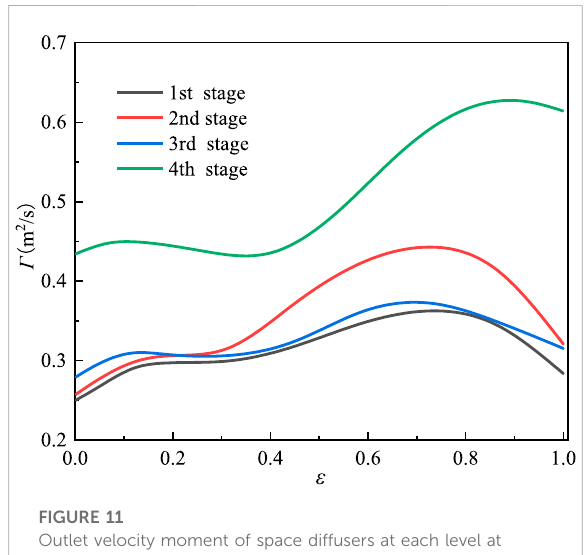
FIGURE 11 Outlet velocity moment of space diffusers at each level at design outlet setting